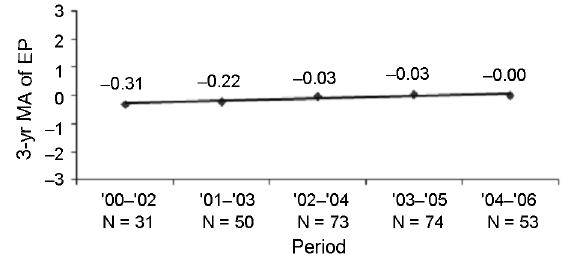
Fig. 5. Engineering productivity trend